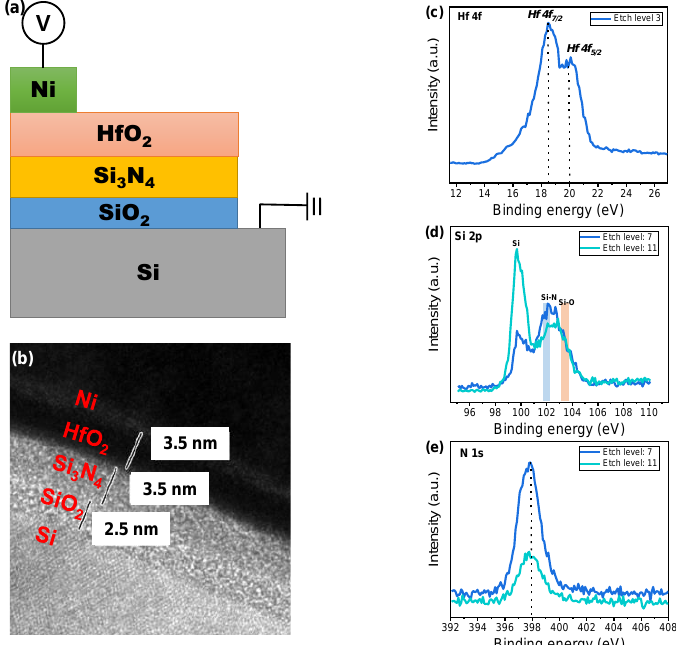
Figure 1. Device configuration and material analysis of the Ni / HfO 2 / Si 3 N 4 / SiO 2 / Si device. ( a ) Schematic drawing of the device stack; ( b ) TEM image; ( c ) XPS Hf 4f spectra at etch level 3; ( d ) XPS Si 2p spectra at etch levels 7 and 11; and ( e ) XPS N 1s spectra at etch levels 7 and 11.